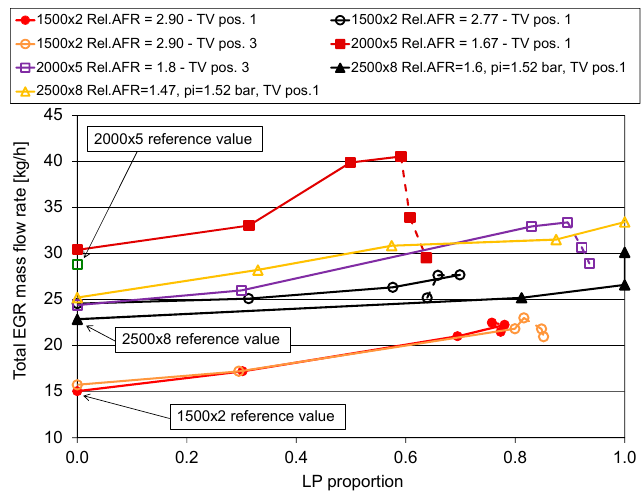
Figure 7. Total EGR mass flow rate as a function of LP proportion in different operating modes.